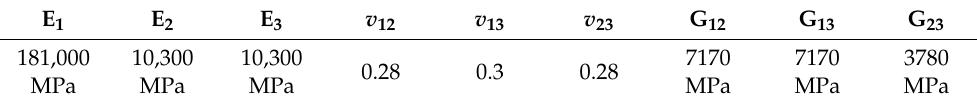
Table 3. Material properties of T300/5208